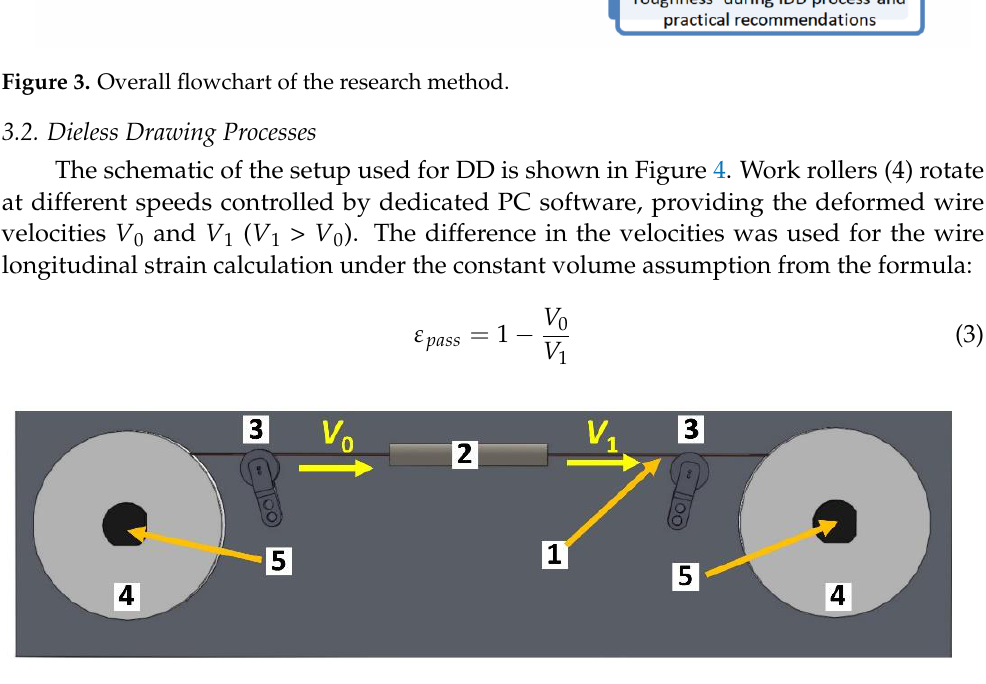
Figure 4. Scheme of the equipment for dieless drawing: 1 — wire; 2 — heating device; 3 — support rollers; 4 — work rollers; 5 — electric stepper motors.